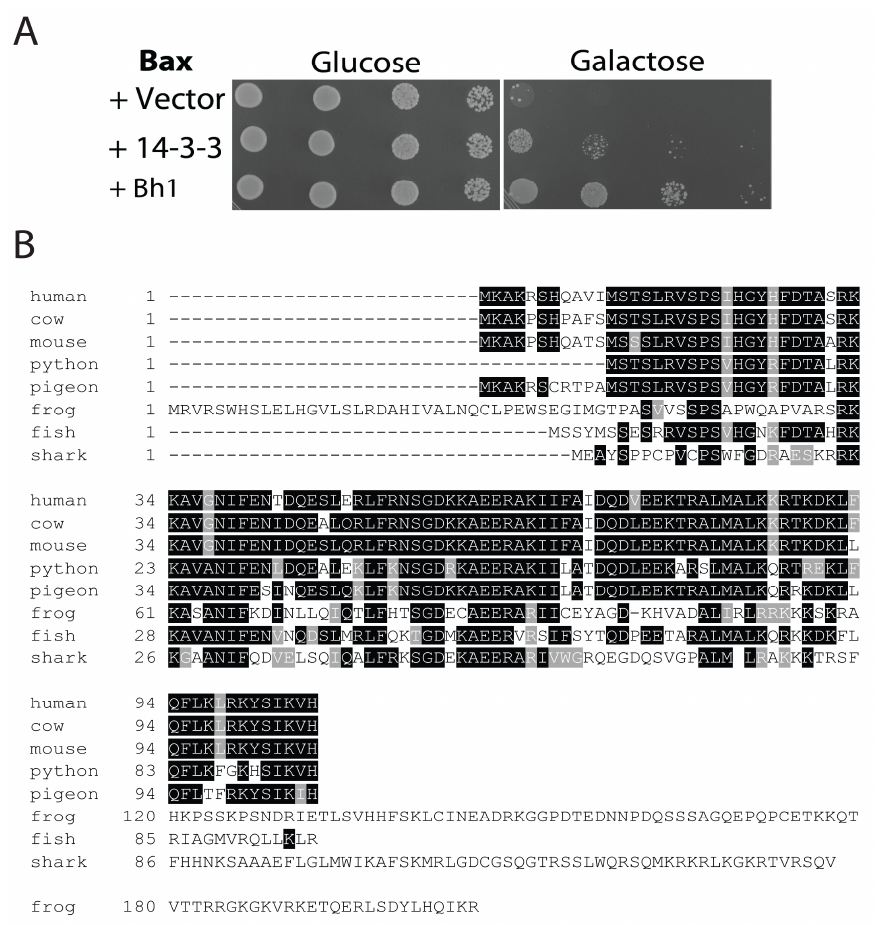
while grey indicates